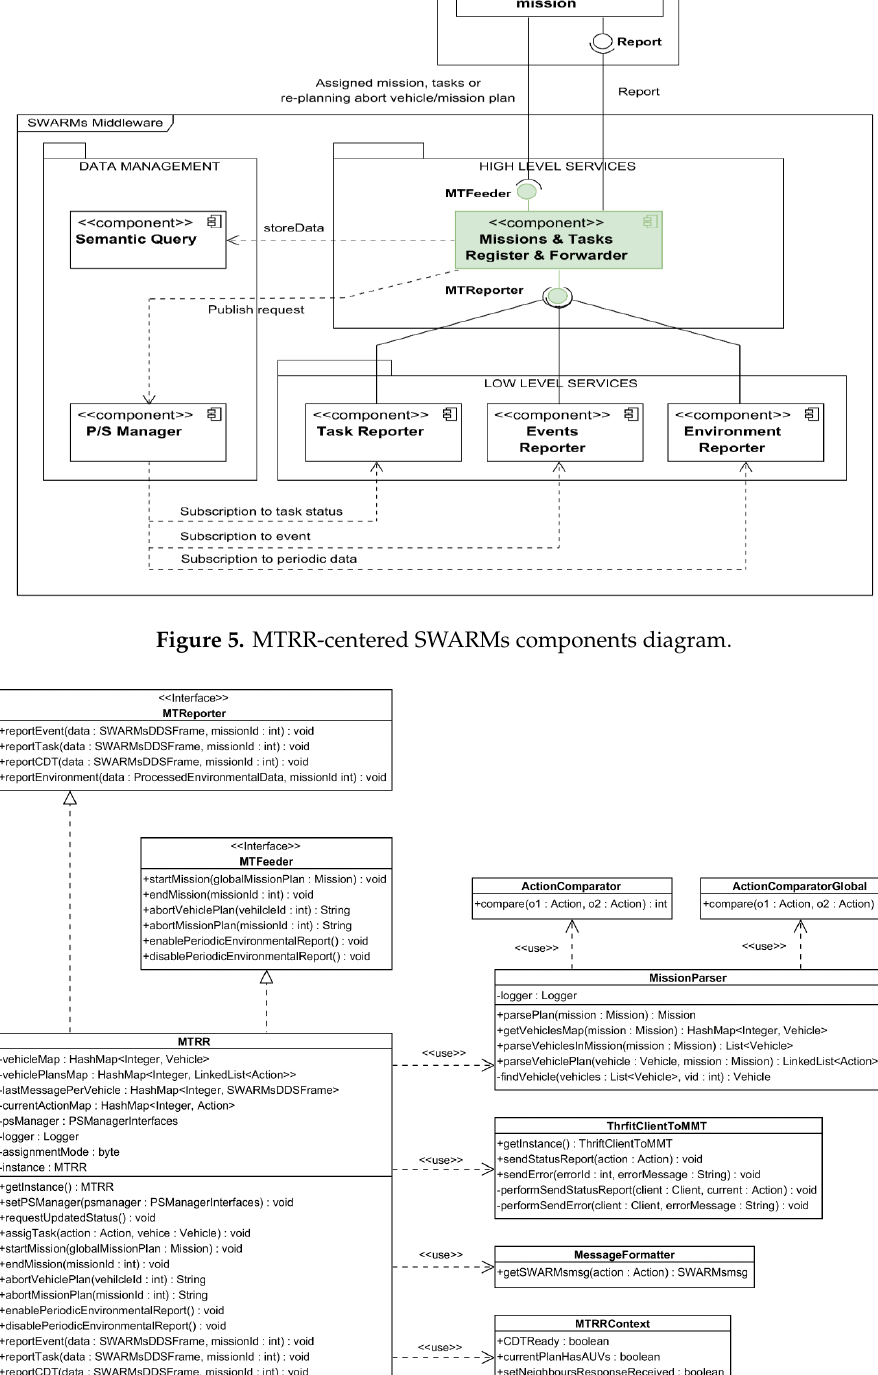
Figure 5. MTRR-centered SWARMs components diagram.